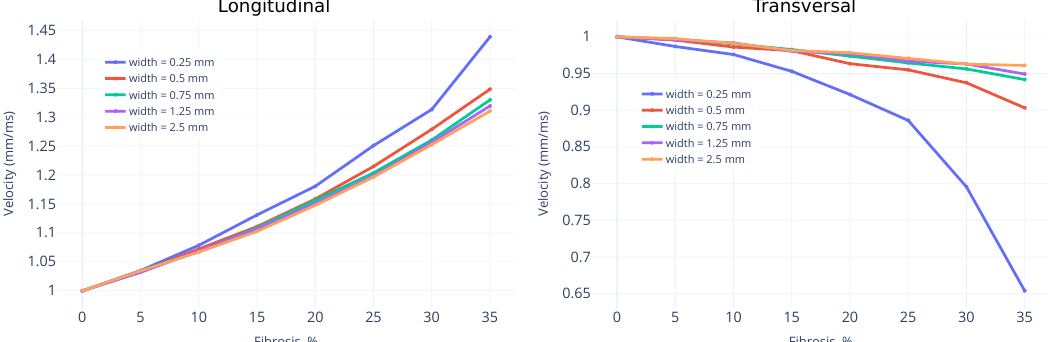
Figure 9. Ratio in the conduction velocities between the average CV for the model with fibrosis of 1 mm (n = 4) obstacle length and the model of diffuse fibrosis (n = 1) of the same percentage. ( Left ) longitudinal wavefront direction. ( Right ) transversal direction. The curves show dependences of the ratio on the fibrosis percentage at varying tissue depth from 0.25 to 2.5 mm (1 to 10